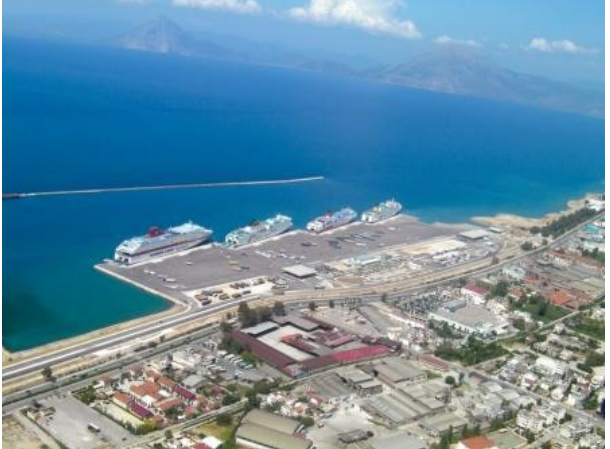
Figure 5: The South Port or else known as New